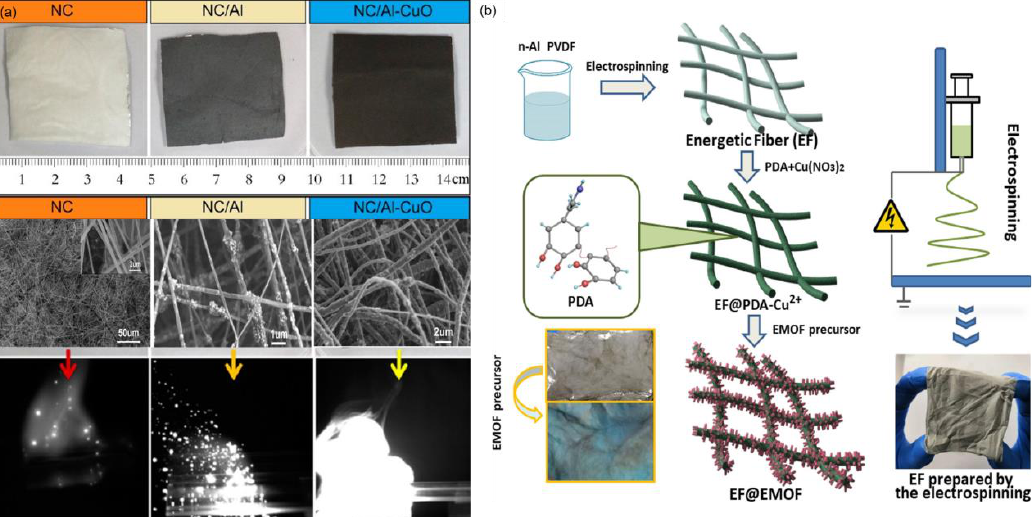
Figure 9. ( a ) The optical and SEM image of pure NC, NC/Al (50 wt%) and NC/Al-CuO (50 wt%), followed by the respective burning static snapshot [120] Copyright 2012, ACS Applied Materials Interfaces, and ( b ) the general procedures for the preparation of n-Al@PVDF/EMOF (DHBT) [121] Copyright 2020, Chemical Engineering Journal.